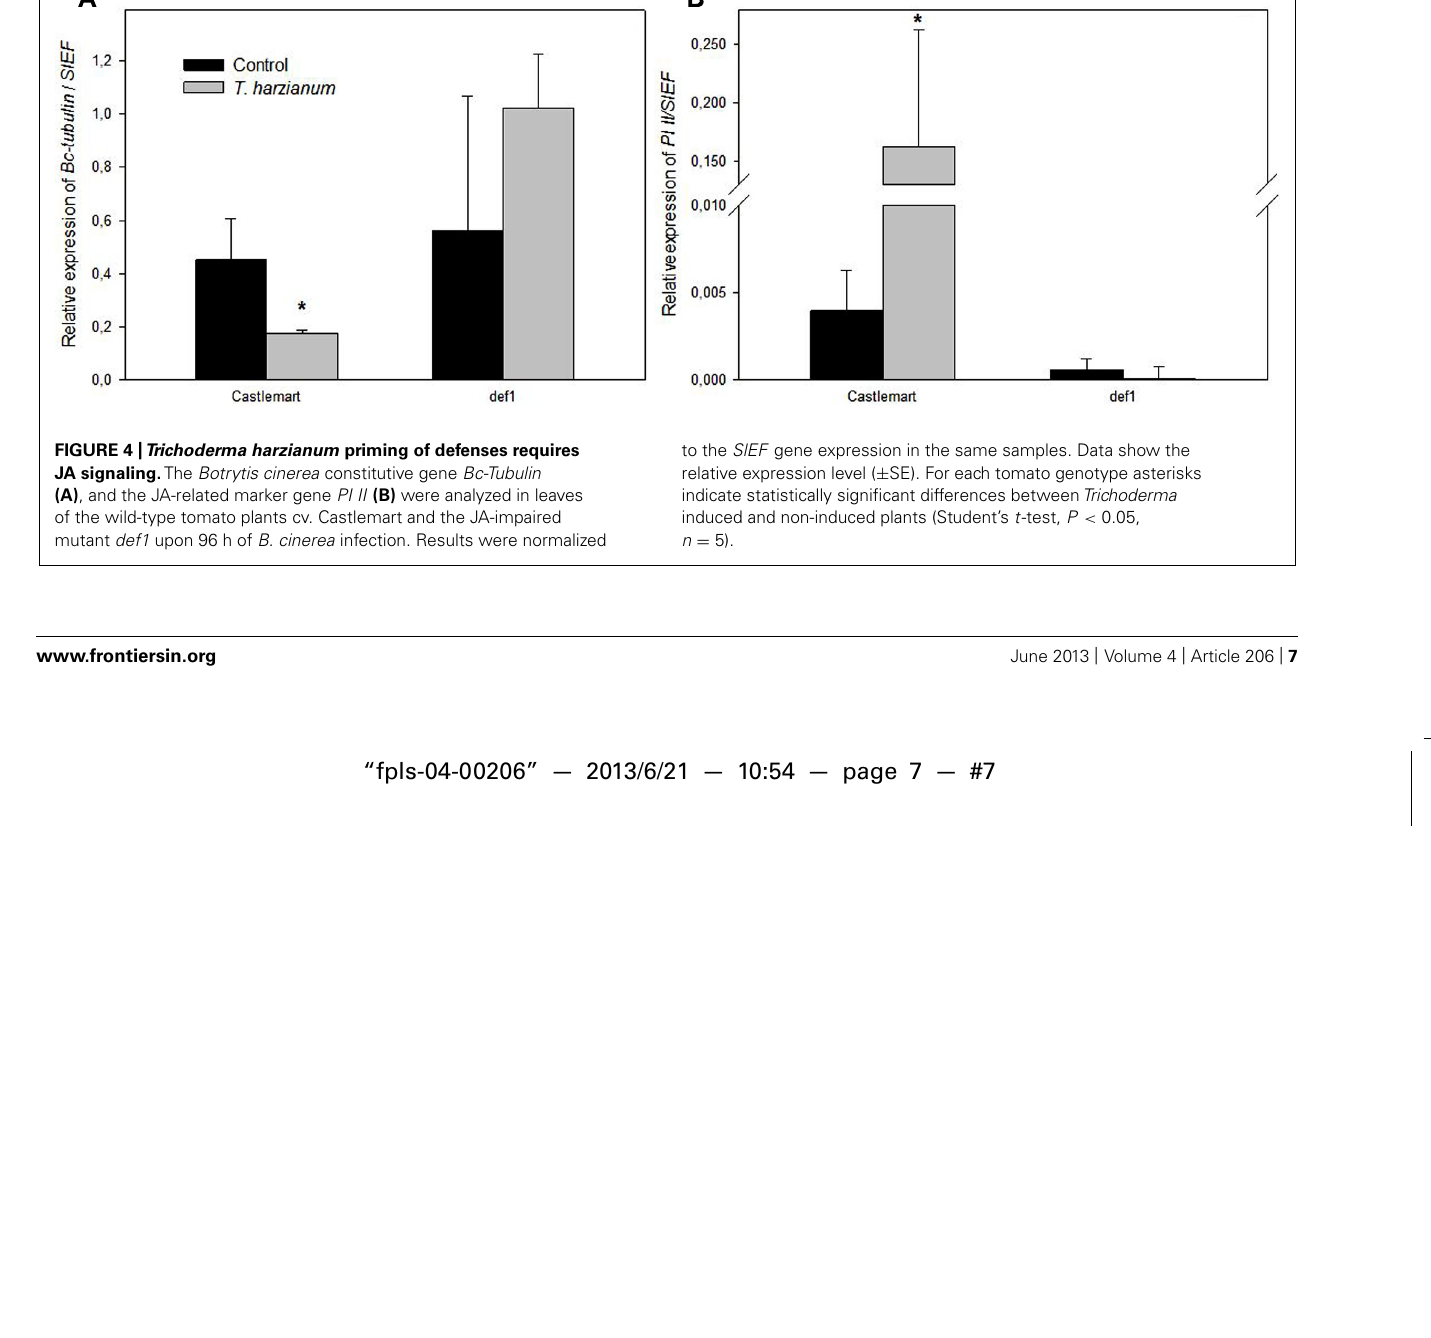
FIGURE 3 | Trichoderma primes JA-regulated responses. The expression of different defense-related marker genes was analyzed in T. harzianum inoculated and non-inoculated (control) plants (cv. Moneymaker) 96 h upon pathogen infection (A) and before infection (B) . Expression levels of the JA-related marker genes PI II , MC , and PS ; and the ABA-related marker gene